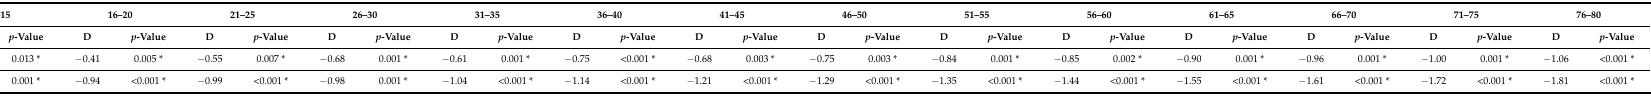
Table 4. Intra-group differences of pressure exerted (N/cm 2 ) at 5-s intervals from